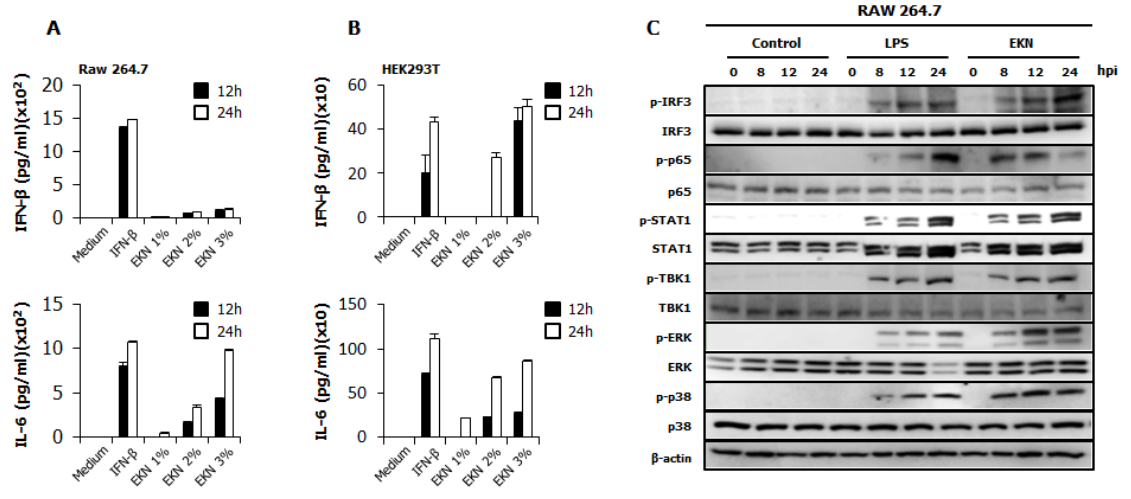
Figure 3. Induction of cytokines and the phosphorylation of the signal molecules by Epimedium koreanum Nakai in vitro . ( A ) RAW264.7; and ( B ) HEK293T cells were treated with DMEM containing 10% FBS alone, with 1000 unit/mL recombinant mouse or human IFN-β, or with 1.0 μg/mL Epimedium koreanum Nakai (EKN) and incubated at 37 °C